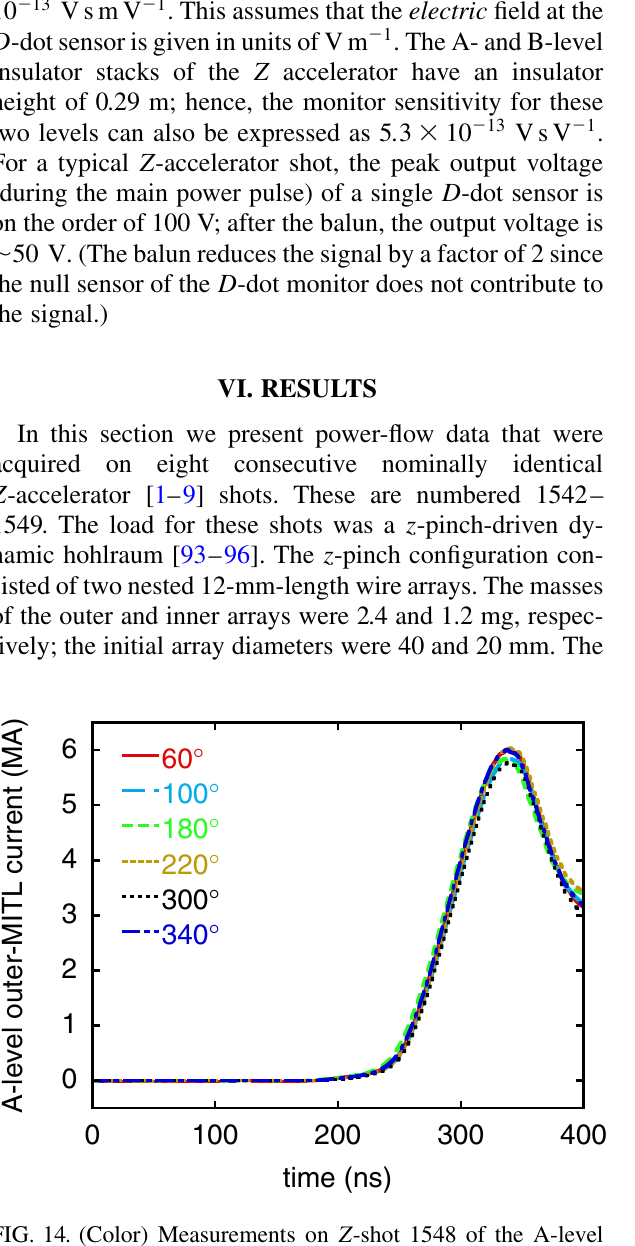
FIG. 16. (Color) Measurements on Z -shot 1548 of the total insulator-stack, outer-MITL, and inner-MITL